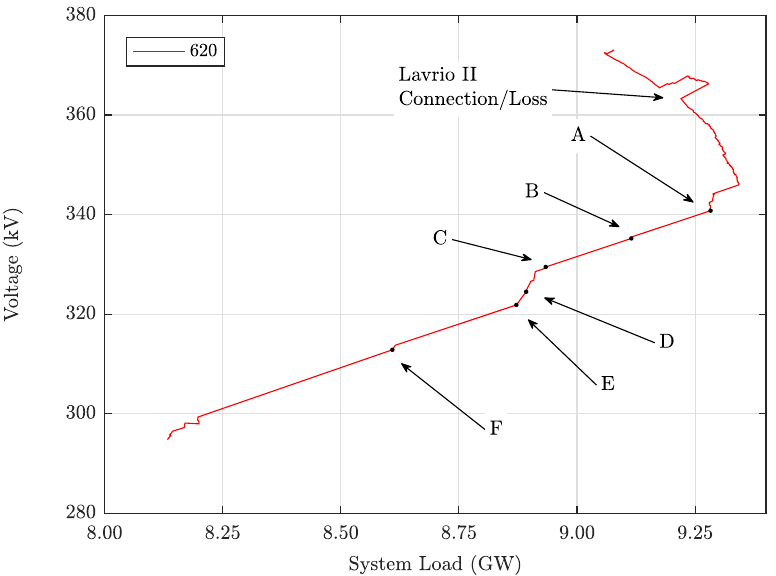
Figure 5. National PV curve (for bus# 620), unstable scenario. Letters A–F refer to Table 2.